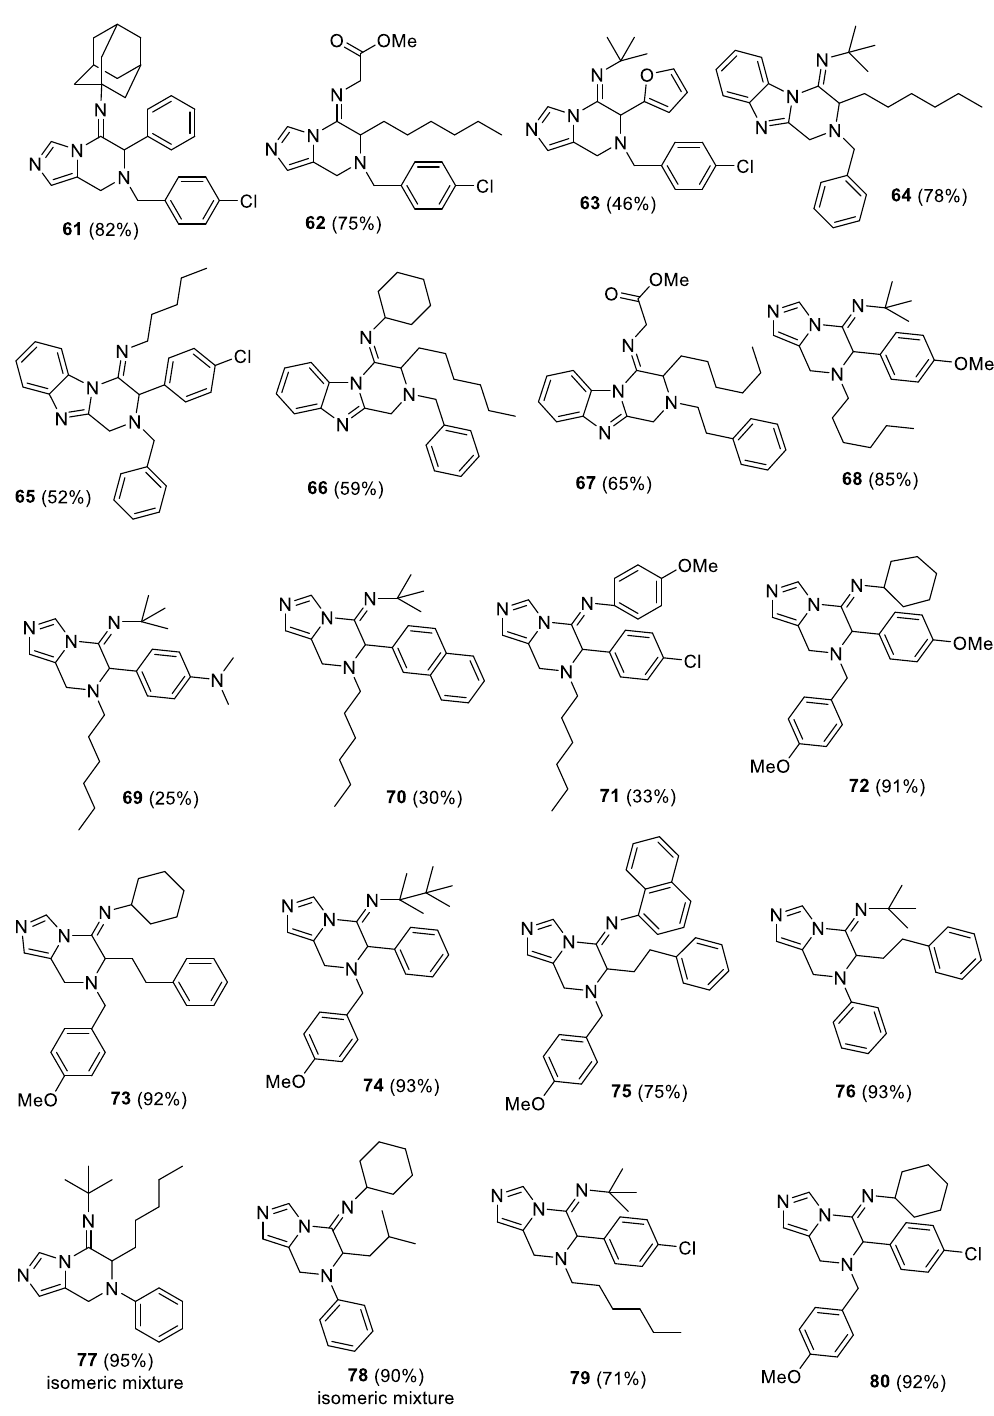
Figure 4. Synthesized imidazopyrazines (continued).